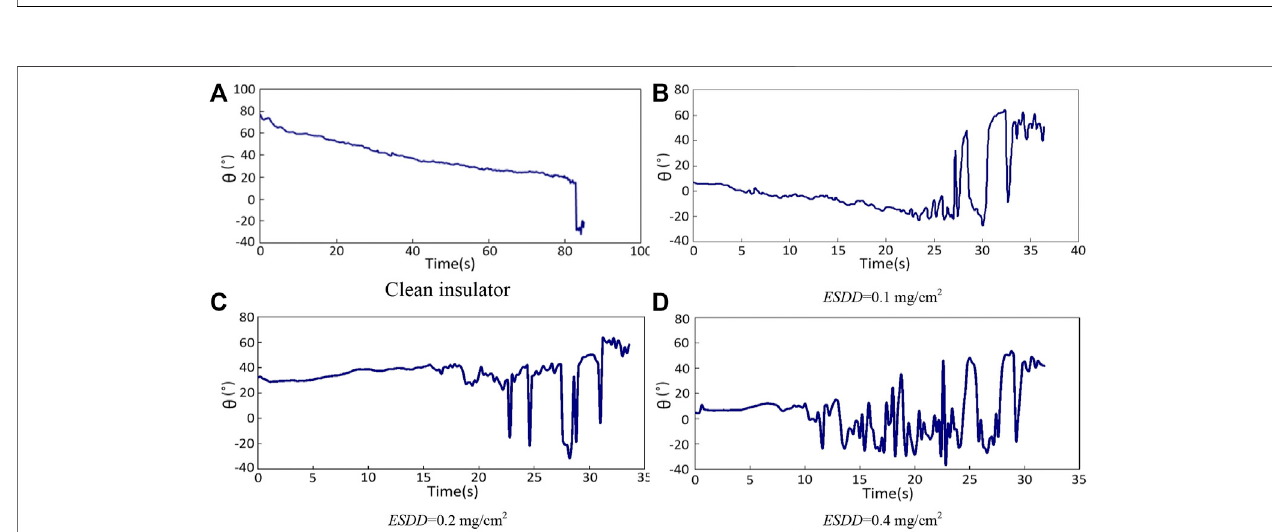
FIGURE 5 | Curves of LC with the increasing voltage.